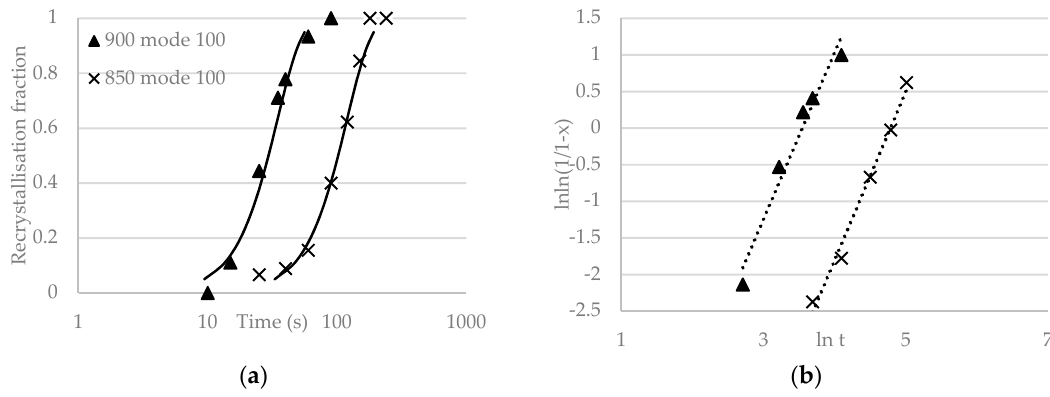
Figure 5. Recrystallisation kinetics ( a ) and double log diagram ( b ) for 100 µm mode grain size samples